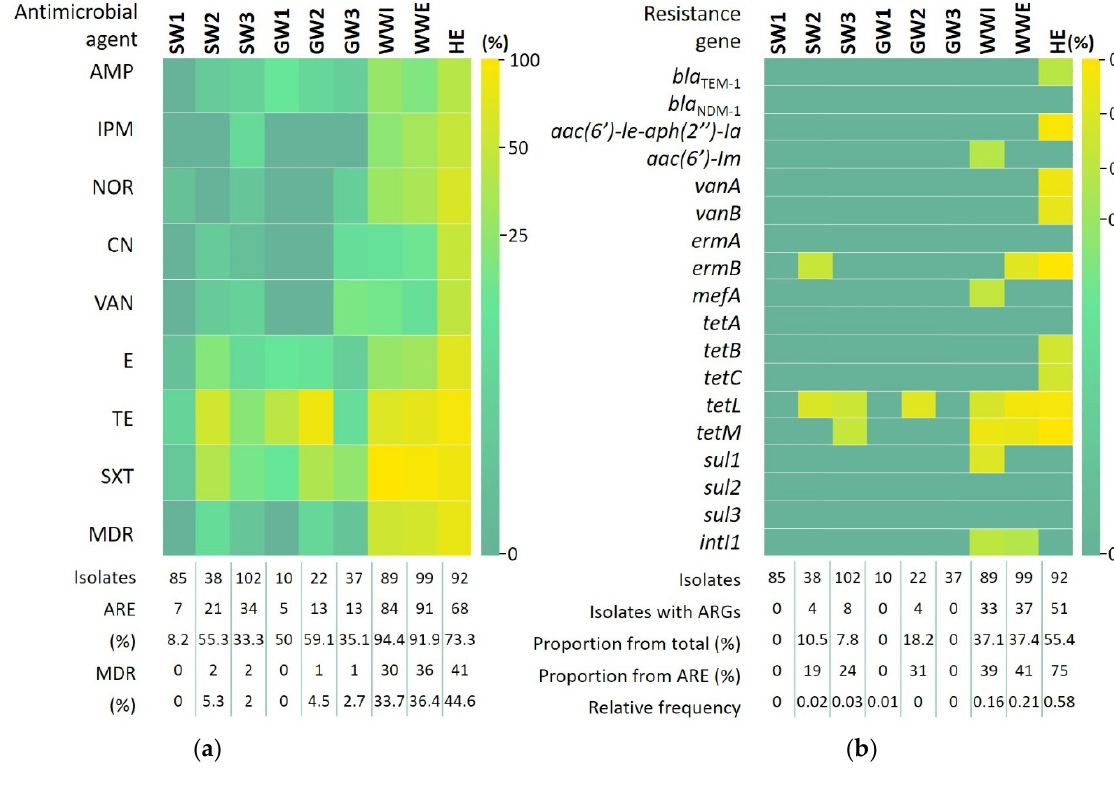
Figure 1. Phenotypic ( a ) and genotypic ( b ) antibiotic resistance of Enterococcus spp. isolates. AMP = ampicillin; ARE = antibiotic resistant enterococci; ARGs = antibiotic resistance genes; CN = gentamicin; E = erythromycin; GW = groundwater; HE = hospital effluent; IPM = imipenem; MDR = multidrug resistance; NOR = norfloxacin; SXT = trimethoprim-sulfamethoxazole; SW = surface water; TE = tetracycline; VAN = vancomycin; WWE = wastewater effluent; WWI = wastewater influent. Quantile binning method was applied for both heat maps construction. The color code uses green for low values to yellow for high values.